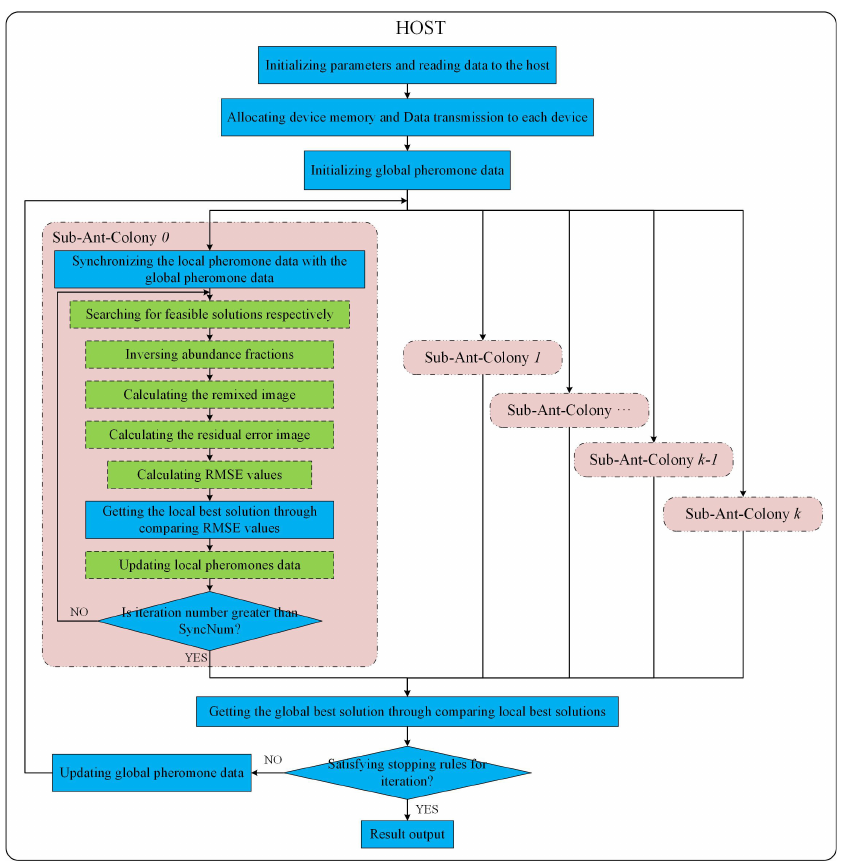
Figure 3. Schematic overview of the implementation of multi-GPU ACO for endmember extraction